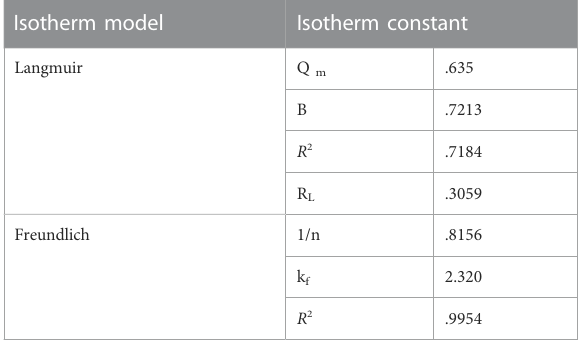
TABLE 2 Isotherm parameters for the adsorption of methyl red over synthesized bionanocomposite. Isotherm